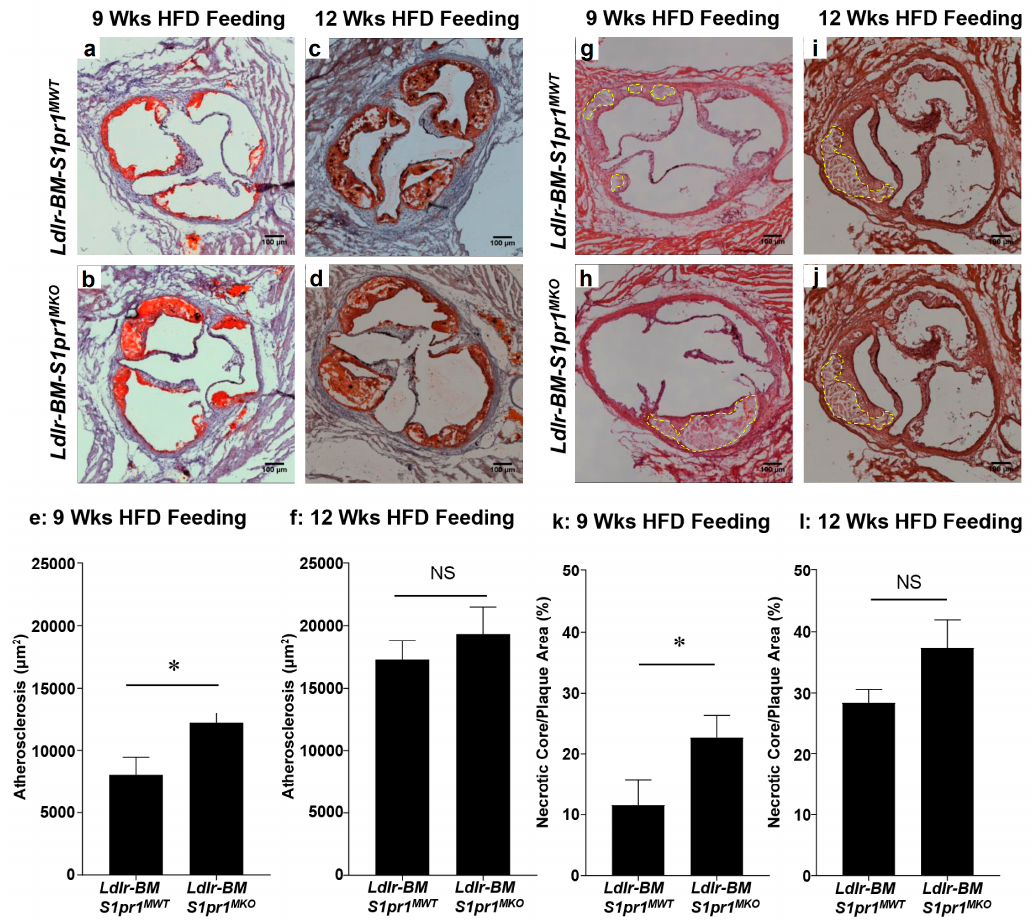
Figure 3. S1pr1 deficiency in BM-derived myeloid cells in Ldlr KO mice accelerates HF-diet